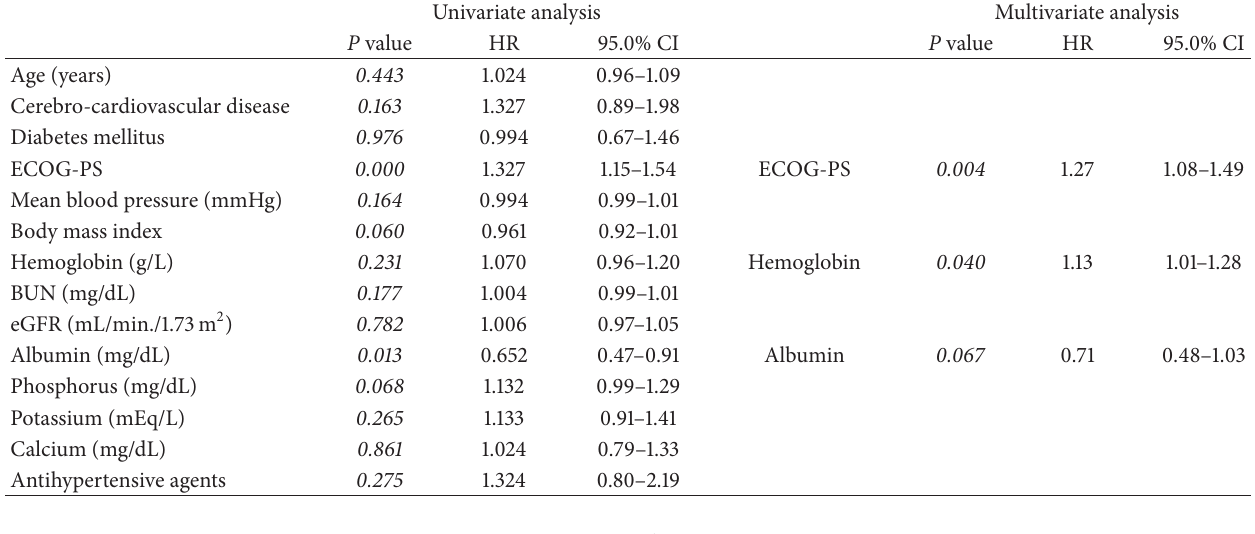
Table 3: Results of univariate and multivariate Cox regression analyses for overall survival in dialysis patients aged ≥ 80 years.